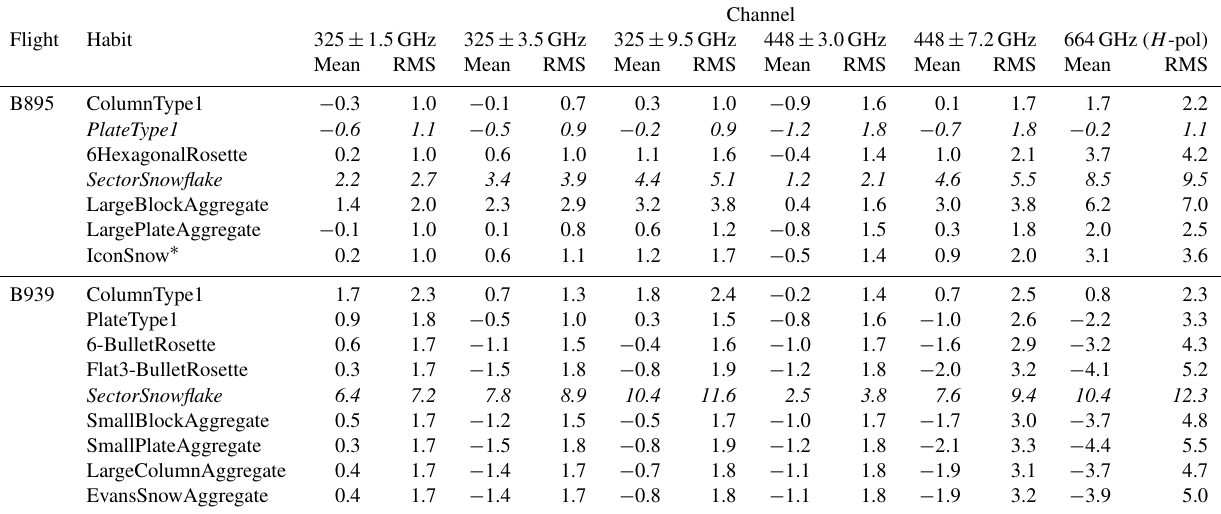
Table 3. Mean and RMS difference between observed and simulated brightness temperatures for each ice crystal habit. The habits in italics are not consistent with the in situ bulk mass but have been included for comparison